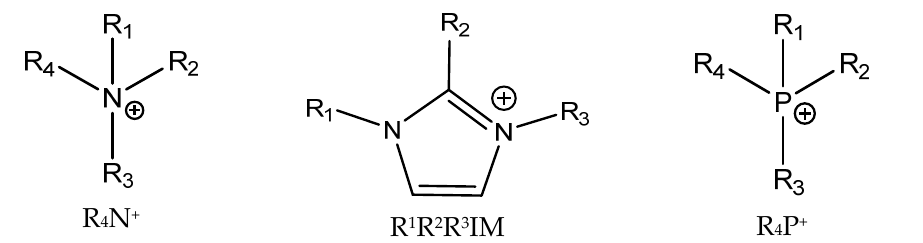
Figure 5. Structures of cations of commonly used ILs.